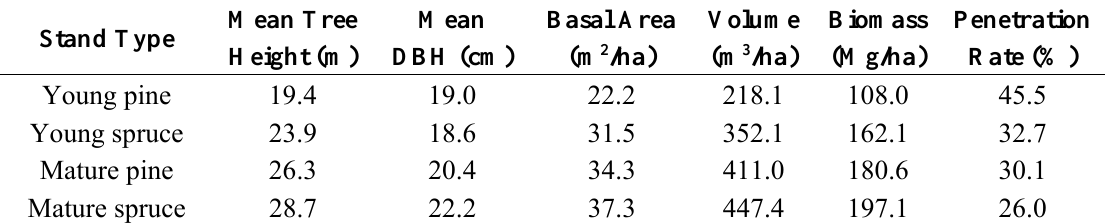
Table 6. General data on the